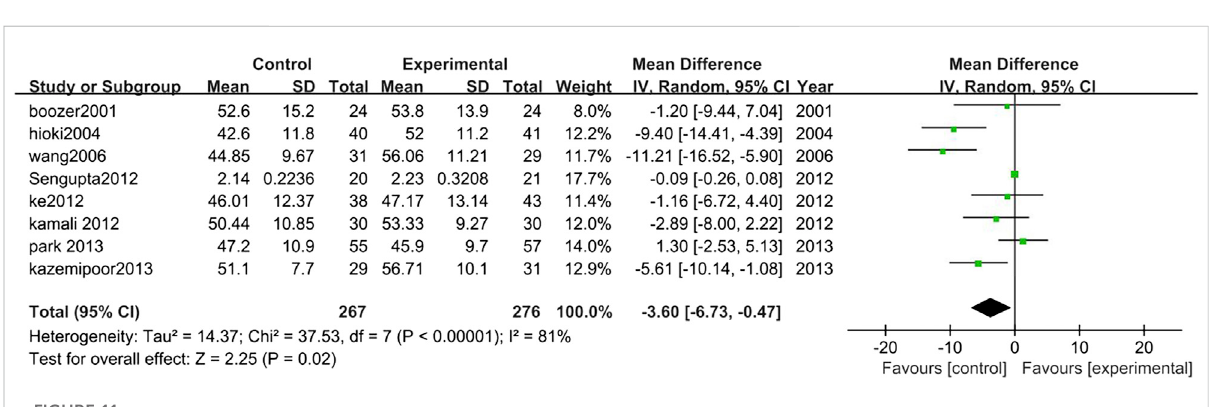
FIGURE 11 Forest plot of HDL. Comparison: TCM treatment vs. placeo or blank